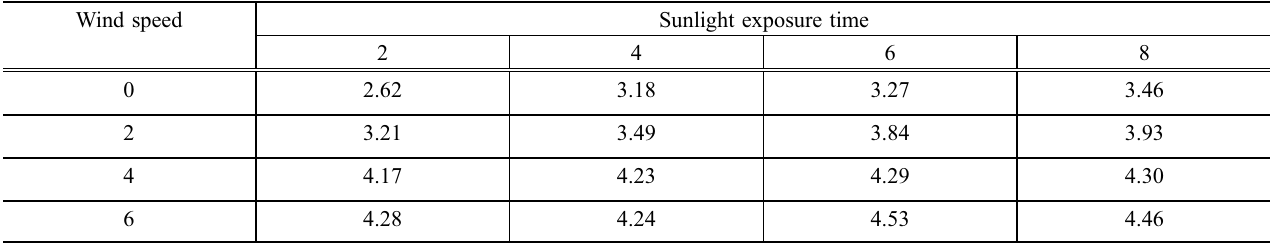
Table 7 Test results of concrete carbonation rate modulus ð unit: mm = ffiffiffiffiffiffiffiffiffiffiffiffi weeks